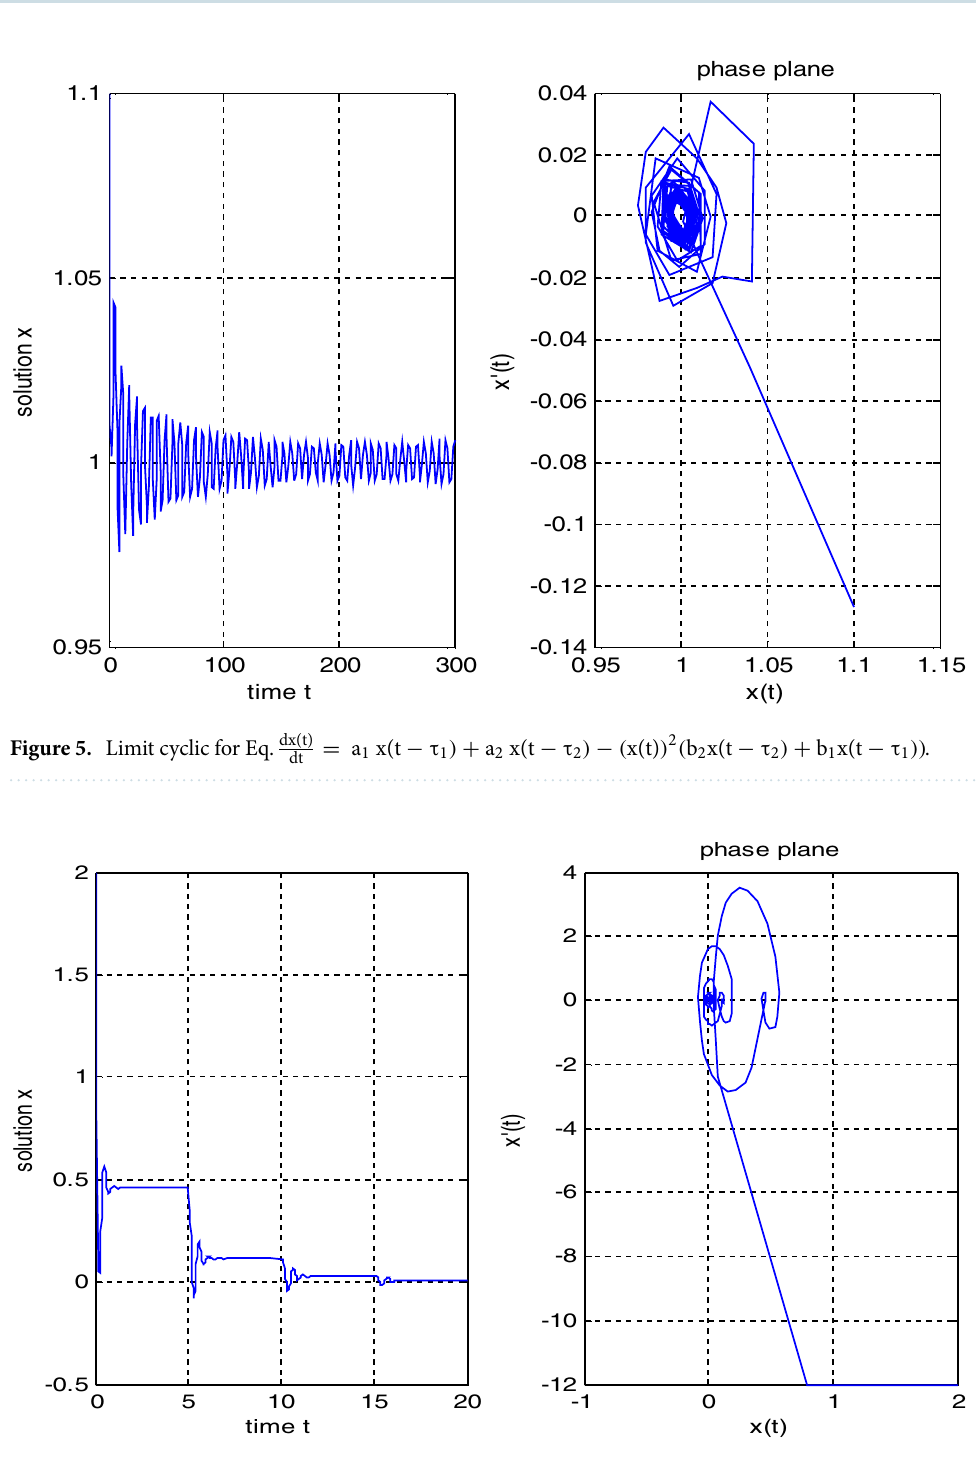
a 1 x(t a 2 x(t τ 1 ) τ 2 dt = − + −